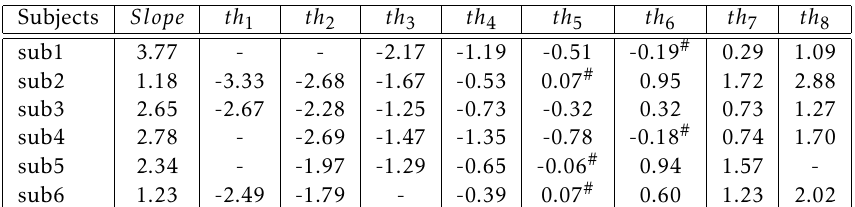
Table 2. Estimated IRT parameters for “Arousal” scale